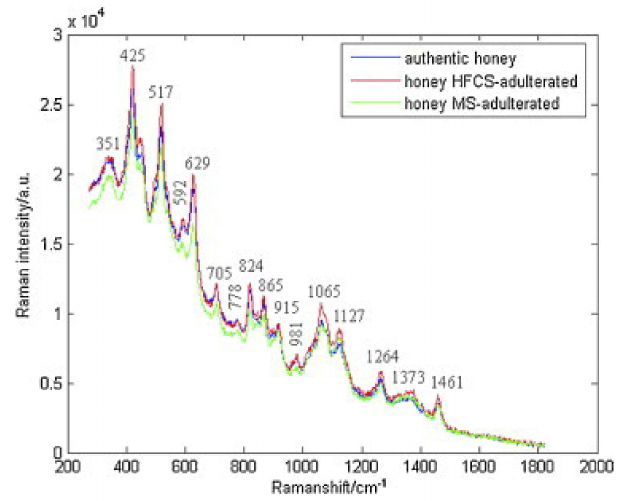
Figure 5. Raman spectra of a randomly selected authentic honey sample and the same honey sample adulterated with high fructose corn syrup (40%, w / w ) and maltose syrup (40%, w / w ). Reprinted with permission from ref. [64]. Copyright 2012 Copyright Elsevier